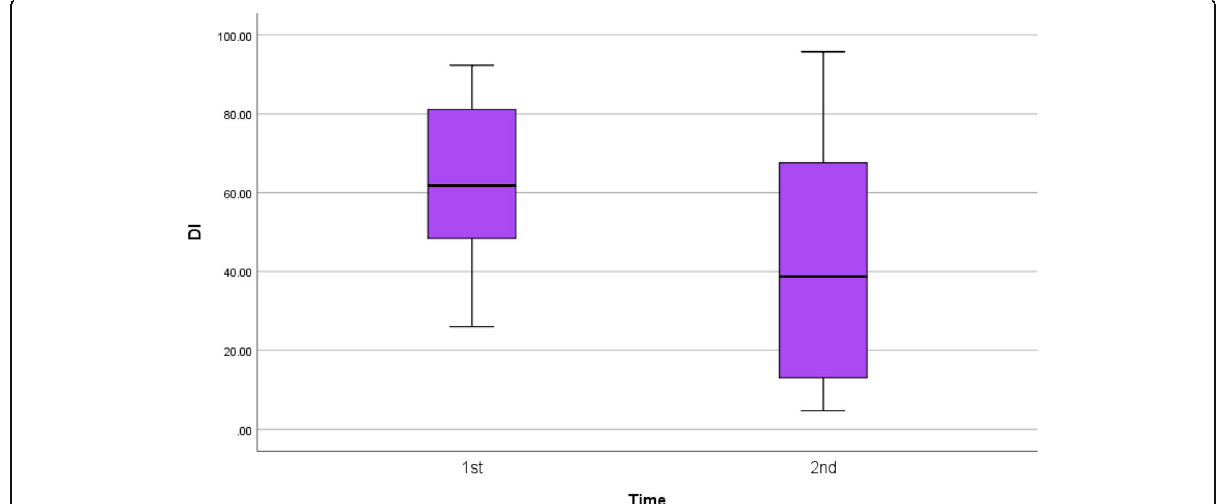
Fig. 1 Degeneration index of the affected side of nasalis among the studied patients